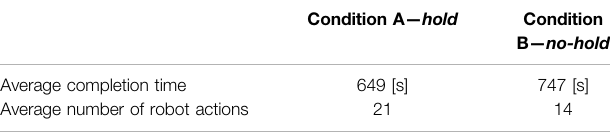
TABLE 2 | Evaluation of the human-robot collaboration.